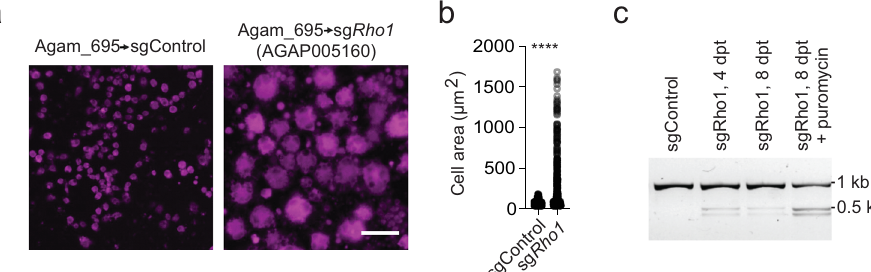
Fig. 4 CRISPR produces highly penetrant phenotypes in the Anopheles CRISPR-ready cell line. a Sua-5B-IE8-Act::Cas9-2A-Neo cells were stably transfected with pLib6.4-Agam_695 donor vector encoding a Rho1 sgRNA, leading to a highly penetrant failure in cytokinesis and dramatically enlarged cell area b Quanti fi cation of cell enlargement (**** P < 0.0001, unpaired t -test, two-tailed, t = 13.45, df = 890, sgControl n = 509, sgRho1 n = 383). mCherry signal (purple), scale bar, 50 μ m. c T7 Endonuclease I assay con fi rming genomic editing in cell populations following 4 or 8 days post-transfection (dpt) without or with puromycin selection to enrich for cells expressing Rho1 sgRNA. Experiments in ( a , b ) and ( c ) were repeated three or more times with similar results. Source data for b is provided in the Source Data fi